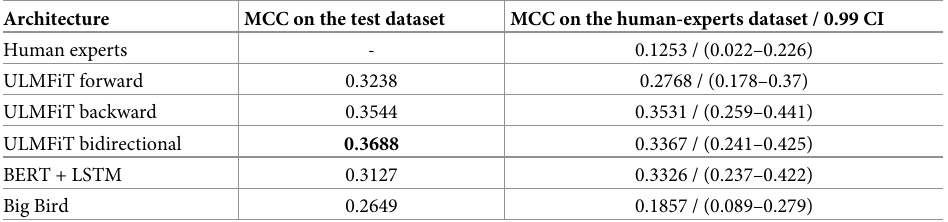
Table 7. Performance results on the human experts dataset and test dataset. We obtained the 0.99 confidence interval based on the Fisher r-to-z